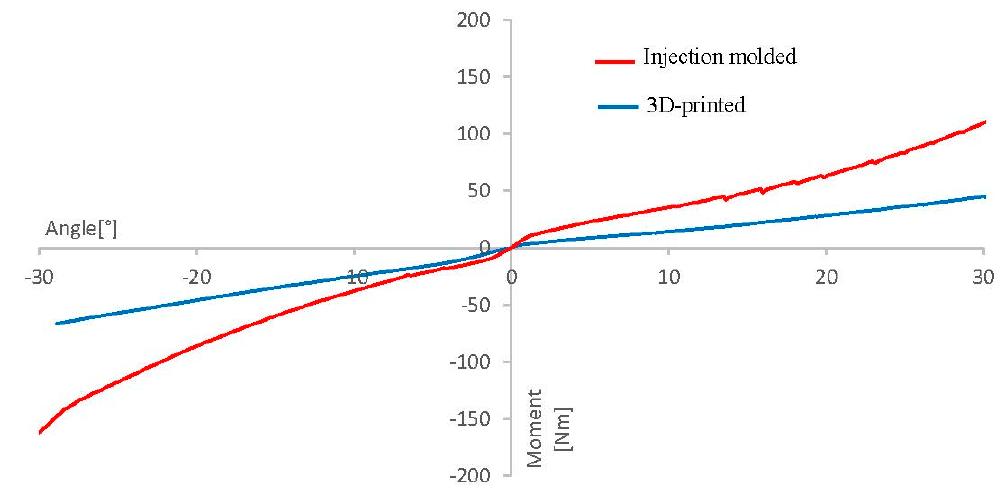
Figure 2. Comparison of dorsiflexion and plantarflexion flex curves of Falcor binding made by injection molding and 3D